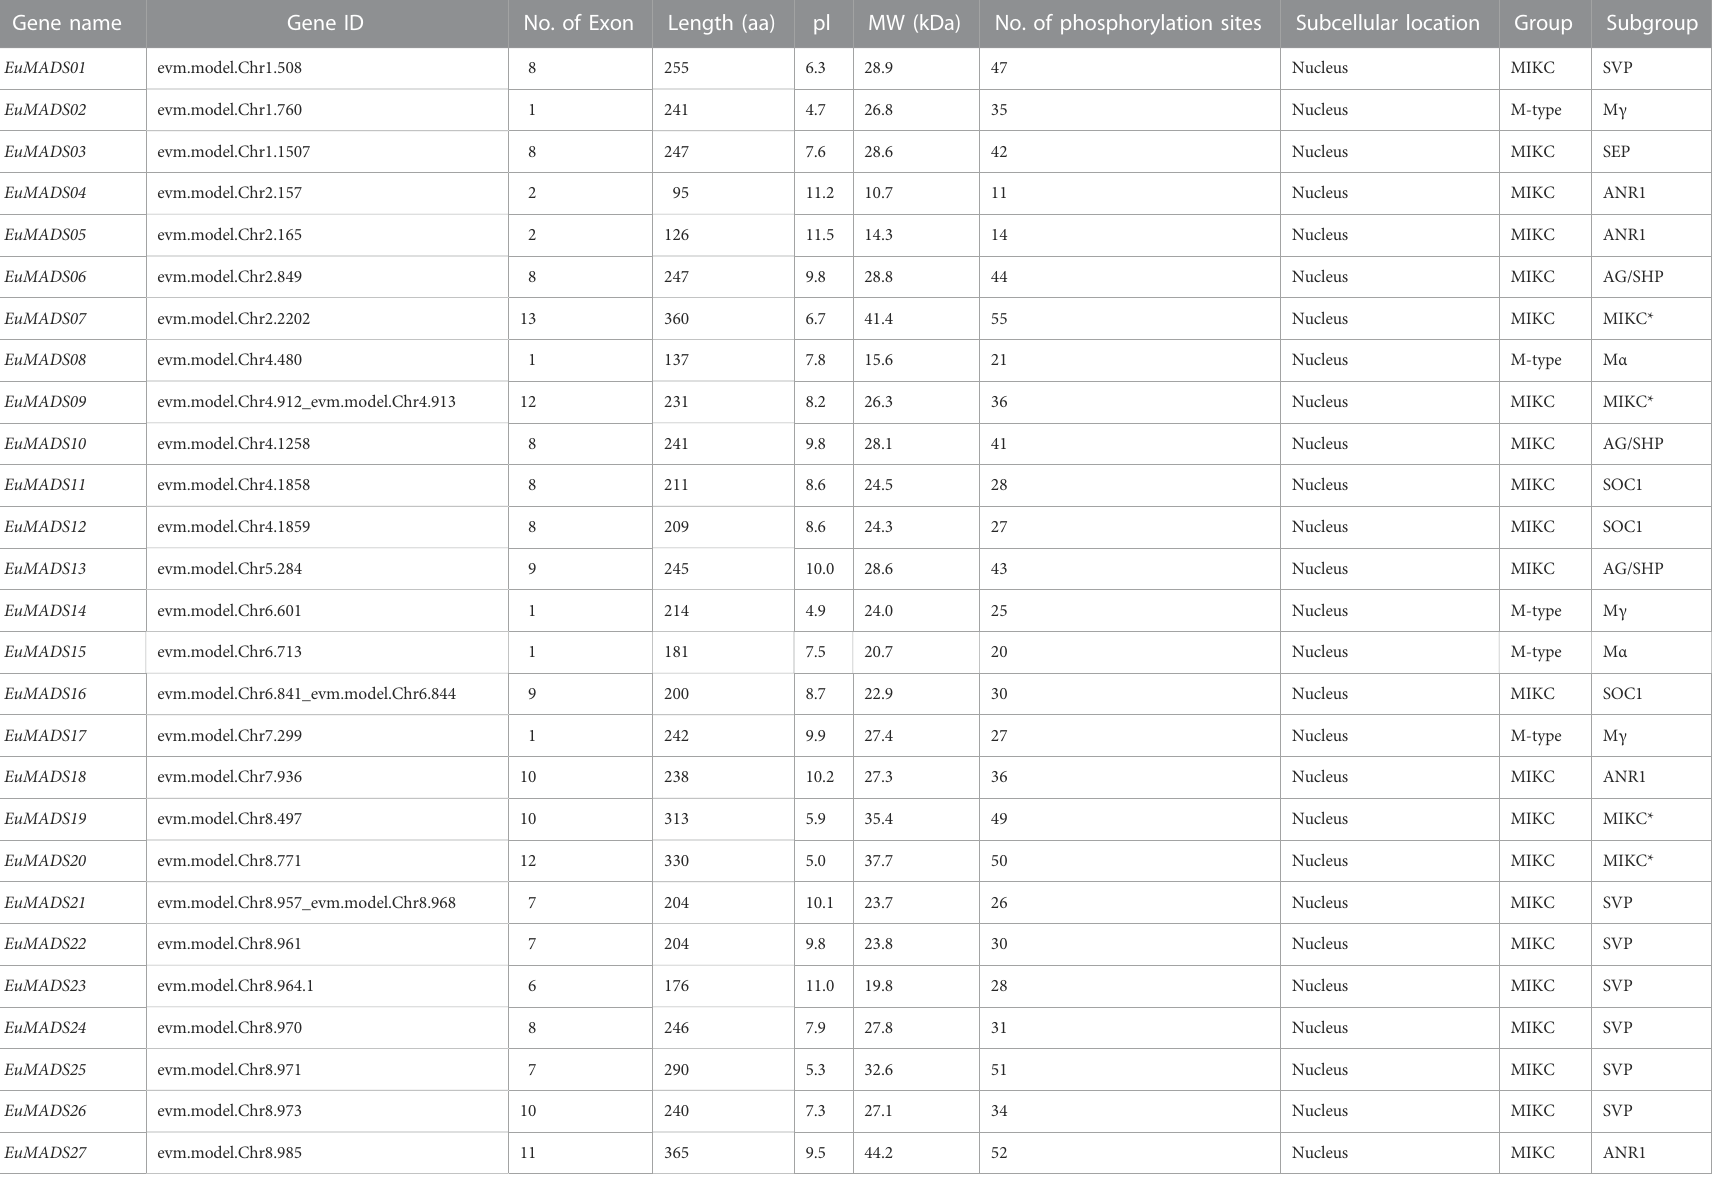
TABLE 1 Detailed information of the EuMADS